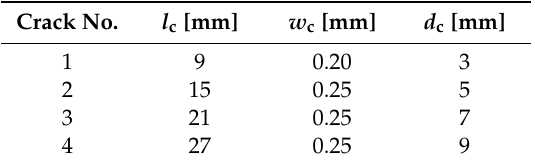
Table 1. Dimensions of the electro-discharge machined (EDM) notches.